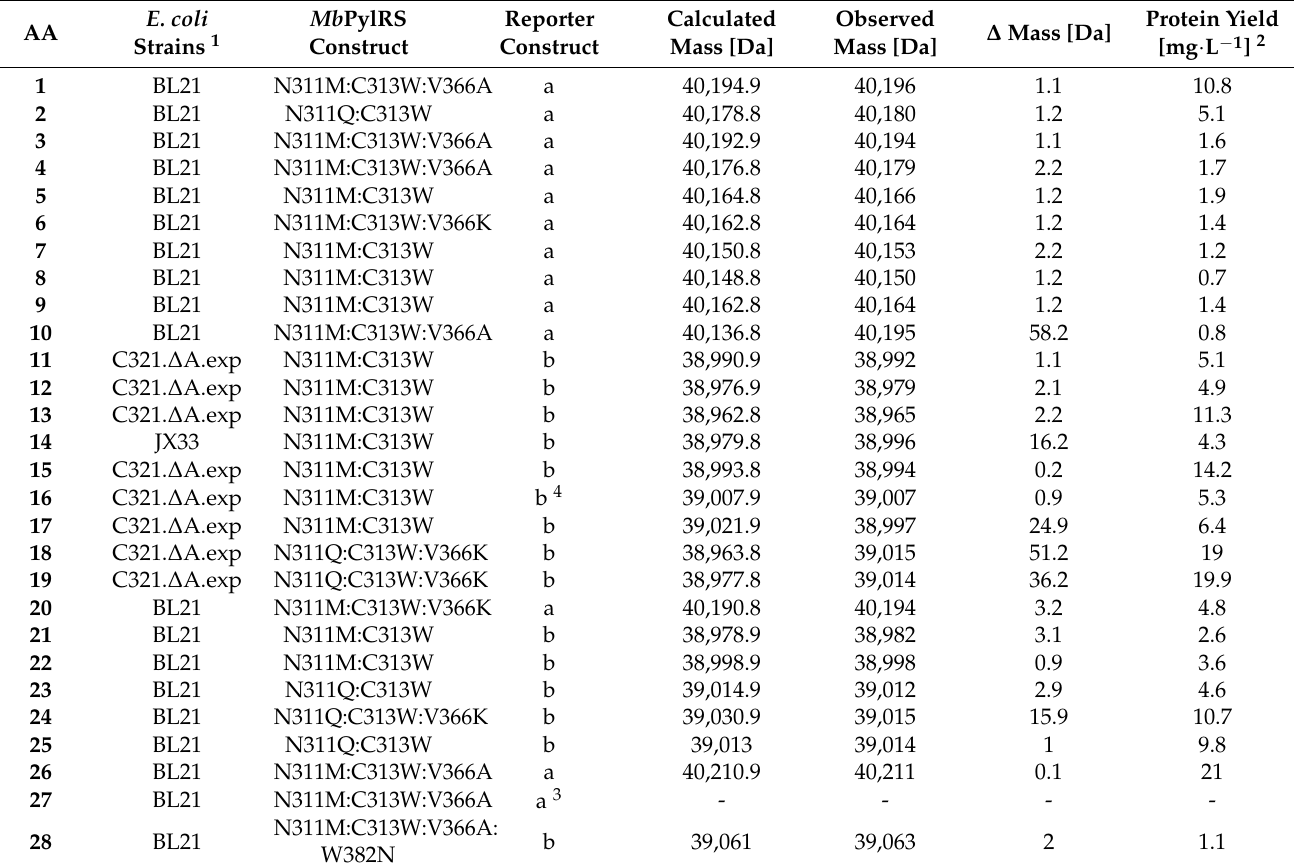
Table 1. Optimal reporter protein production setup, calculated and observed molecular weights of the reporter proteins His 6 -SUMO-sfGFP(R2AA)-strep (a) /SUMO-sfGFP(R2AA)-His 6 (b) and protein production yields per liter of culture. The masses were determined by ESI-MS of intact